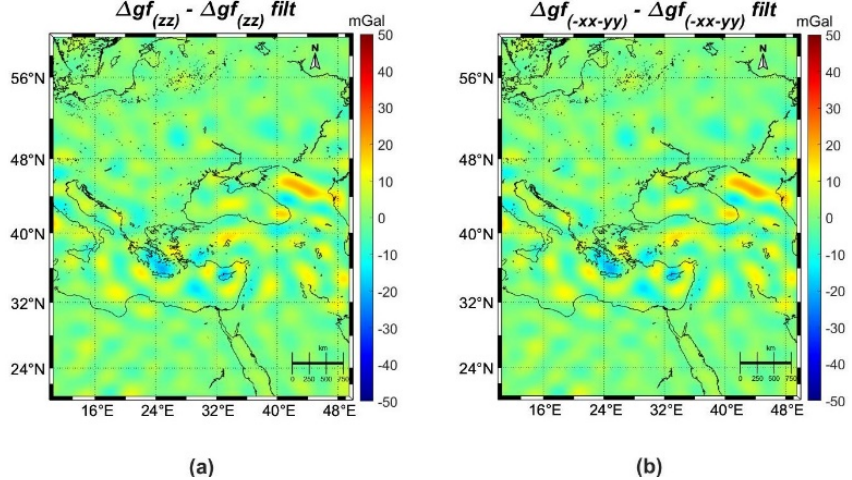
Figure 9. ( a ) The difference between the DC solutions from the T MO zz filt and T MO − xx − yy filt tests, ( b ) RMSE from T MO zz filt test, ( c ) RMSE from T MO − xx − yy filt test. Table 4. Statistical values of the WL-filtered DC results for the entire GOCE time series.